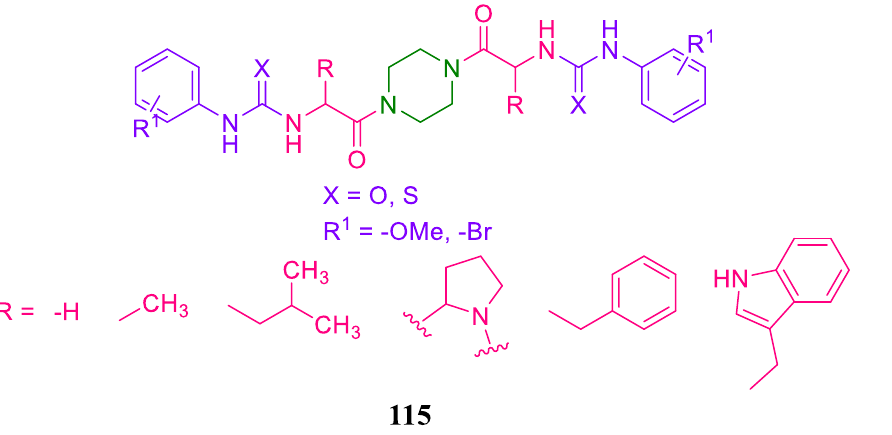
Figure 94. Piperazine-bridged pseudopeptidic thiourea/urea derivatives.